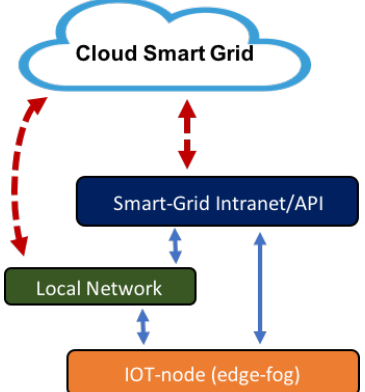
Figure 2. Model layer architecture with the main elements and their relationship. There are two node types: edge and fog. Each facility (building, solar generation, etc.) can have its own local network. All the nodes and all local networks are related to the energy (smart grid) and cloud management layers. The main components of the proposed architecture are defined